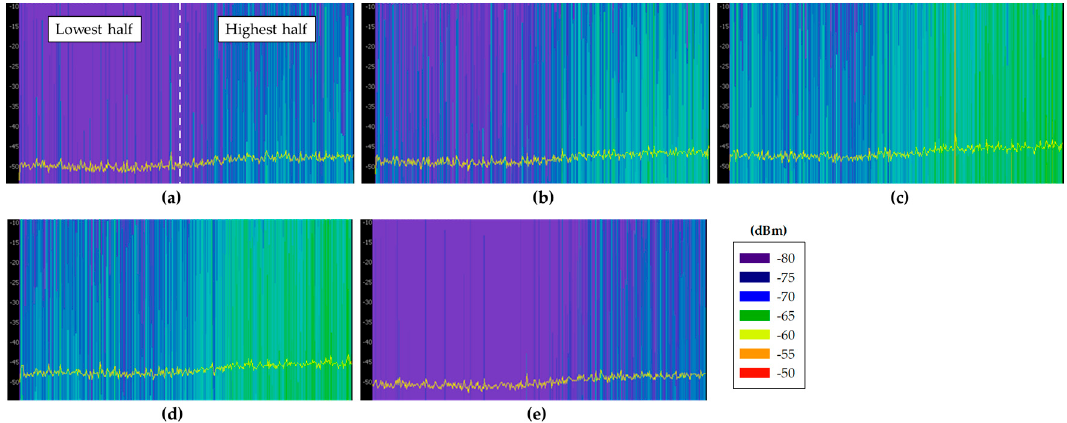
Figure 8. Measured spectrograms at 5.5 GHz center frequency with 600 MHz bandwidth: ( a ) within Box 2; ( b ) within Box 18; ( c ) aisle in front of Box 6; ( d ) aisle in front of Box 18; and ( e ) in the middle of the scenario.